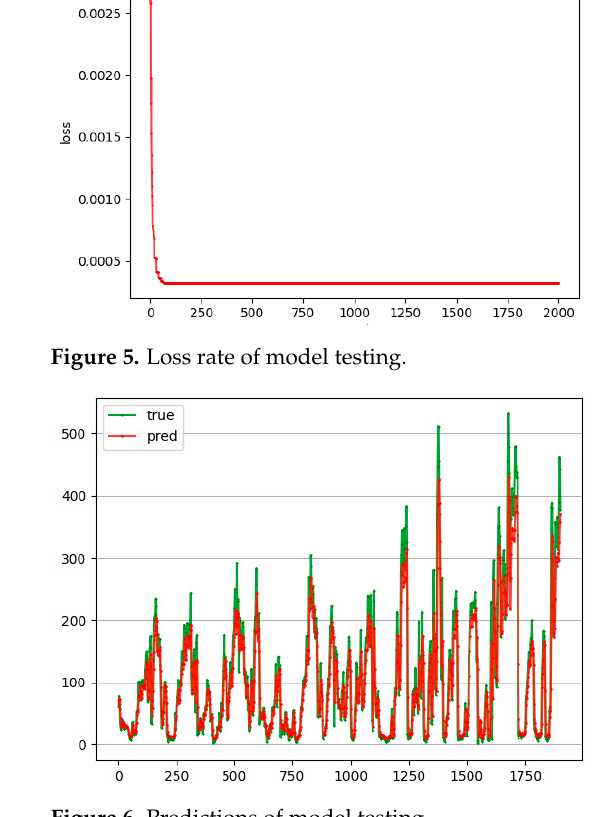
Figure 6. Predictions of model testing.